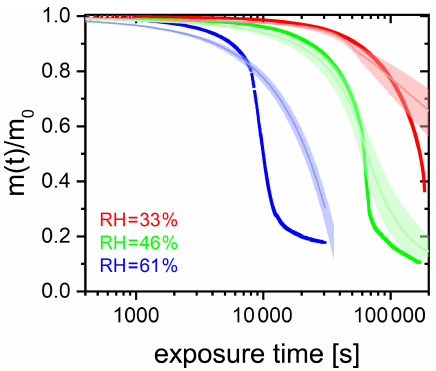
Figure A4. Fe III ( Cit )/ CA (molar ratio 0.05) particle mass change with irradiation time (log scale) at different RH: 33% (red), 46% (green), and 61% (blue). The irradiation wavelength was 375nm, its intensity was 0.25Wcm − 2 , and the experimental temperature was 293.5K. Thick lines are EDB experimental data. Thin lines are PRAD model outputs (with ± 2% RH uncertainty shown as the shaded